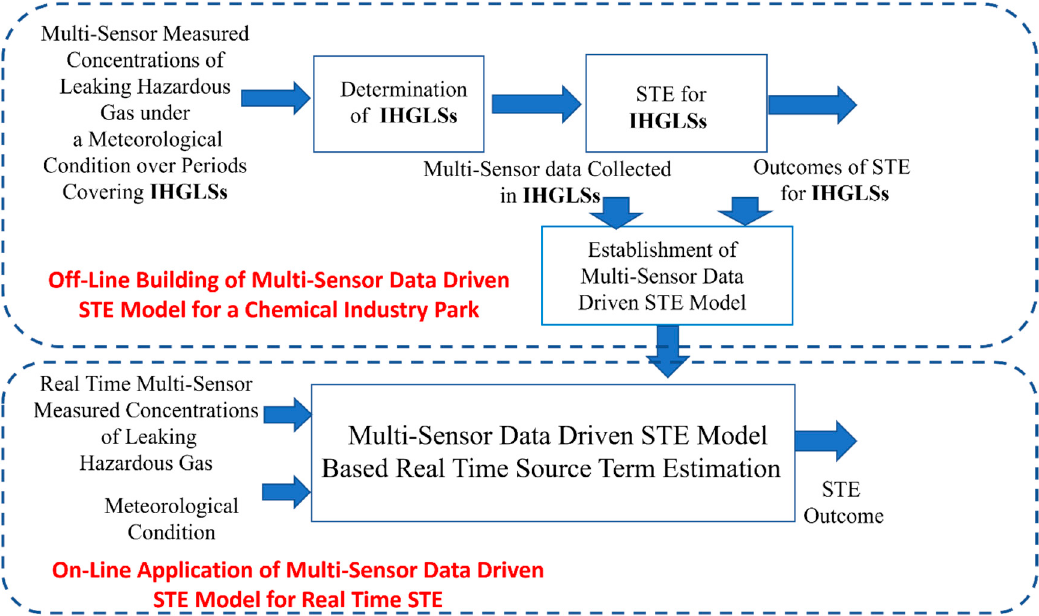
Figure 2. The novel idea of the proposed multi-sensor data-driven STE.